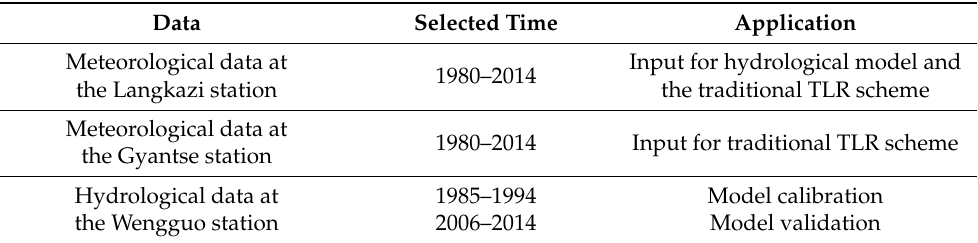
Table 1. Daily observation data used for model input, calibration and